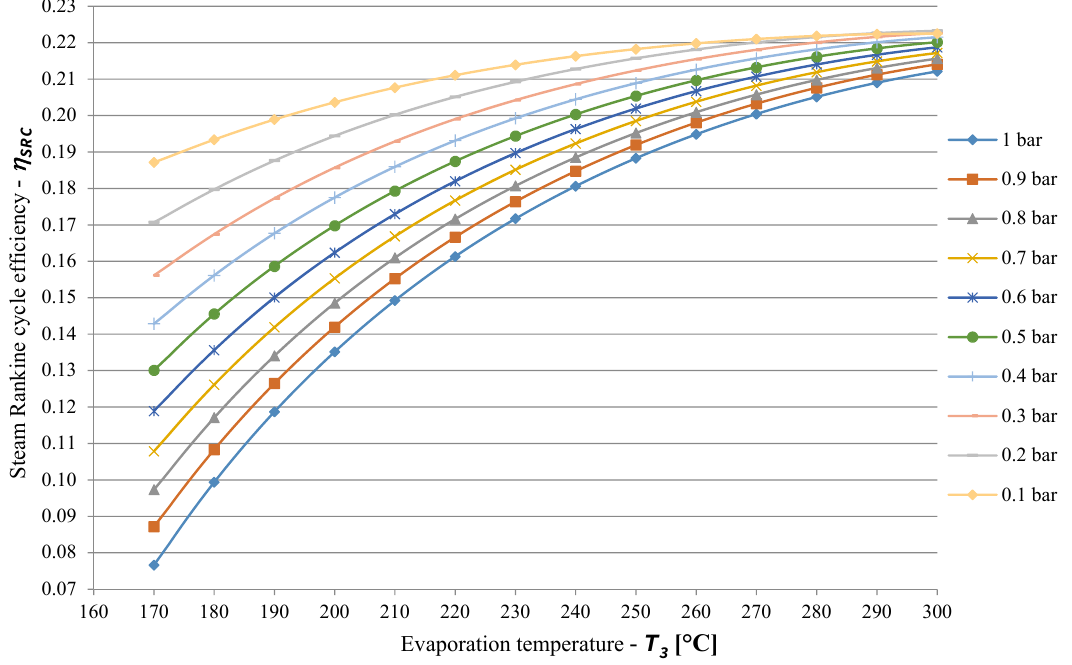
Figure 5. Steam Rankine cycle efficiency calculated against the evaporation temperature under increasing condensation pressure. Reprint with permission [2]; 2020, John Wiley and Sons.